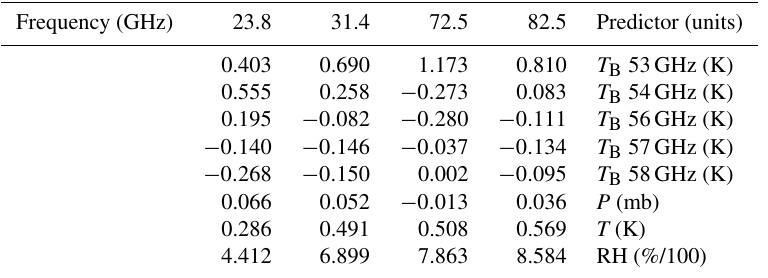
Table A2. D for multivariate multiple linear regression Eqs. (A1)–(A2) to estimate T MR from PTU and T B at five V-band channels. The first row and column respectively indicate the corresponding frequency channel and